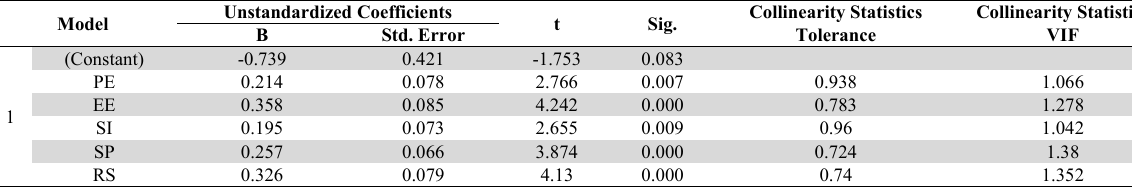
Multiple linear regression model for unused customer group